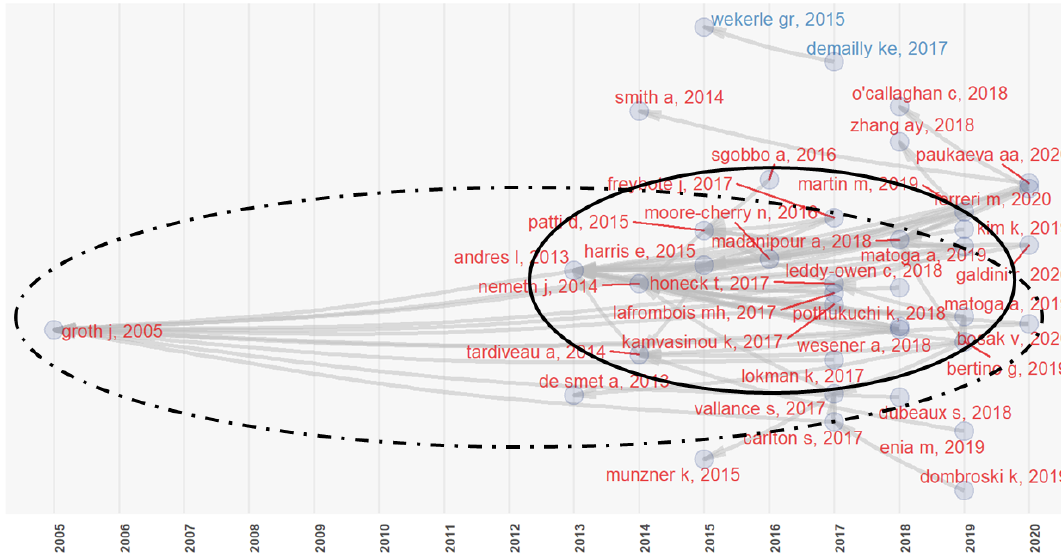
Figure 8. Historical direct citation network of most cited